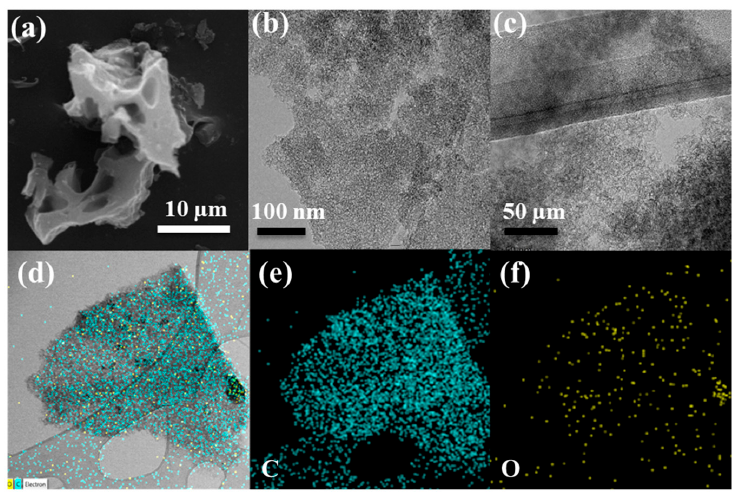
Figure 1. SEM image ( a ), TEM images ( b , c ), Map data ( d ) and elemental mapping ( e , f ) of AC-700.